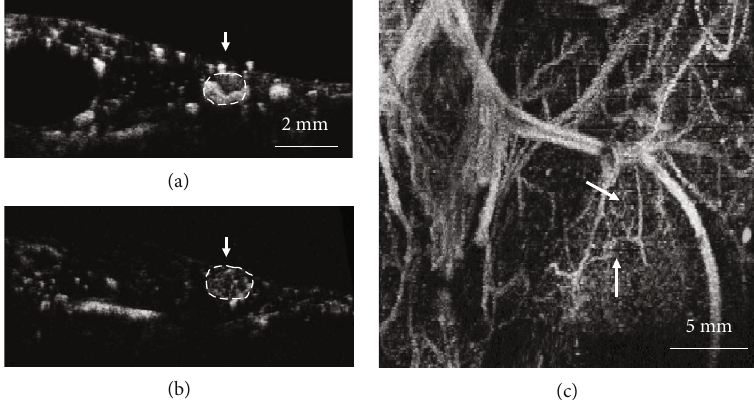
Figure 2: Typical contrast images of microtumors. (a, b) 1.5 and 1.7mm tumors displaying patterns of vascular density, tortuosity, and peripheral enhancement in axial frames. (c) Maximum intensity projection in the coronal view from